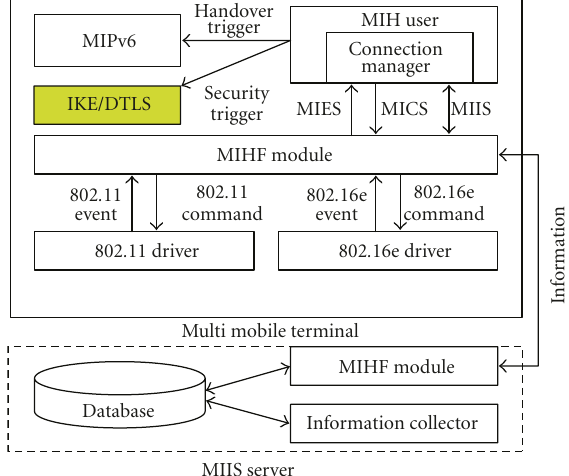
Figure 4: Secure transport module in MIH framework.